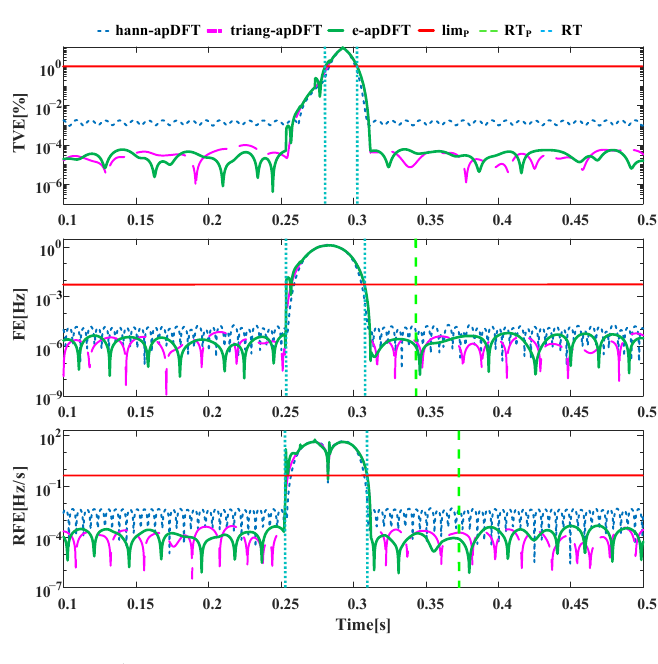
Figure 12. Amplitude ramp test.